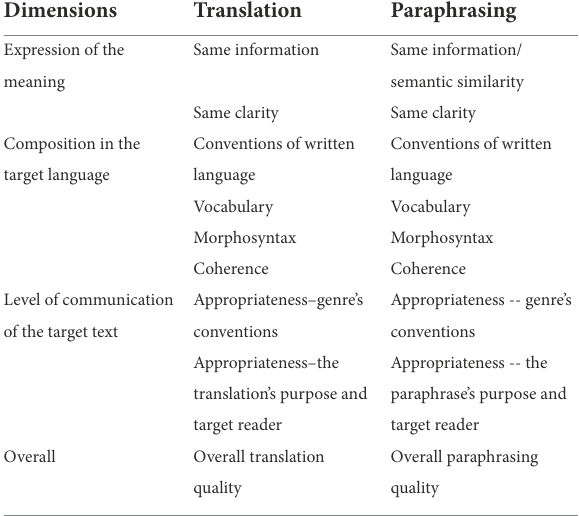
TABLE 1 The selected metrics in the comparative analysis of the quality between translation and